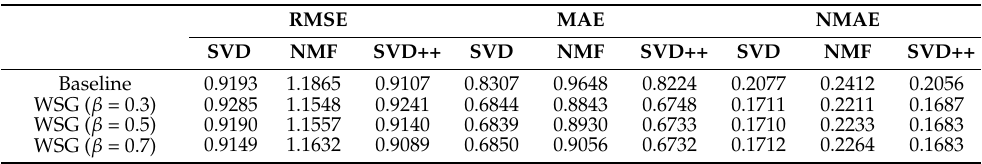
Table 5. RMSE, MAE, and NMAE values with and without L-CNN sentiment and genres-based model and different values of β on the MARD dataset.